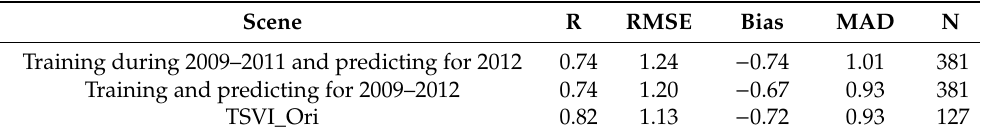
Figure 10. Spatial distribution of ET estimates from TSVI_DNN ( b , d , f ) trained during 2009–2011 and TSVI_Ori ( a , c , e ) on DOY 150, 214, and 283 in 2012 from top to bottom, respectively. Unit: mm d − 1 . Table 3. Error metrics of ET estimates from TSVI_Ori and TSVI_DNN compared with measurements from the EC network in 2012 for two di ff erent scenarios: training using 2009–2011 data to predict ET in 2012 vs. training and predicting ET for 2009–2012, including R (correlation coe ffi cient), RMSE (root and N (the number of